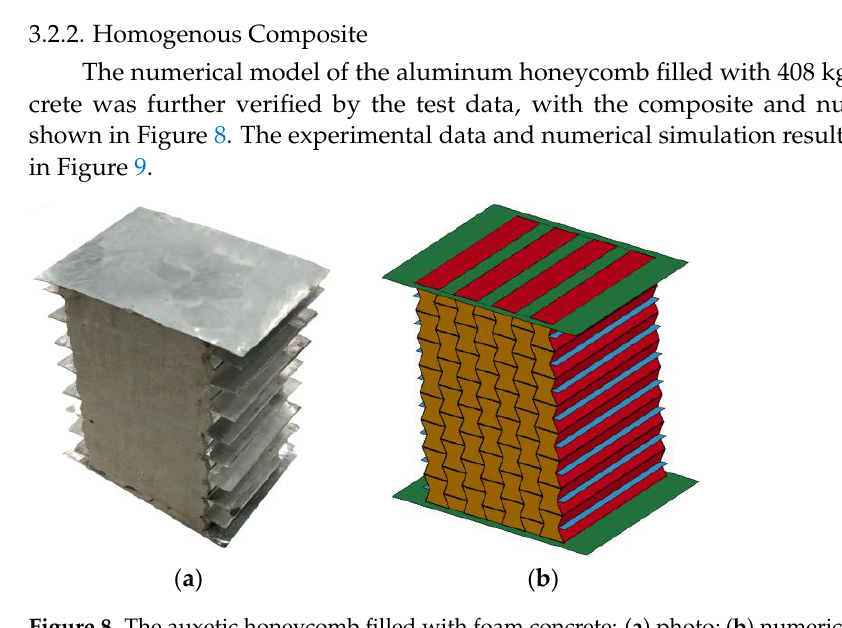
quasi-static and dynamic compression tests.